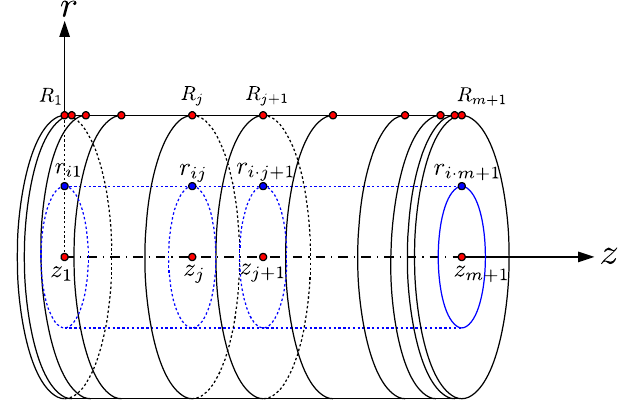
FIG. 1. Bunch segmentation model used for multiple beam envelope equations. This figure shows an initial bunch